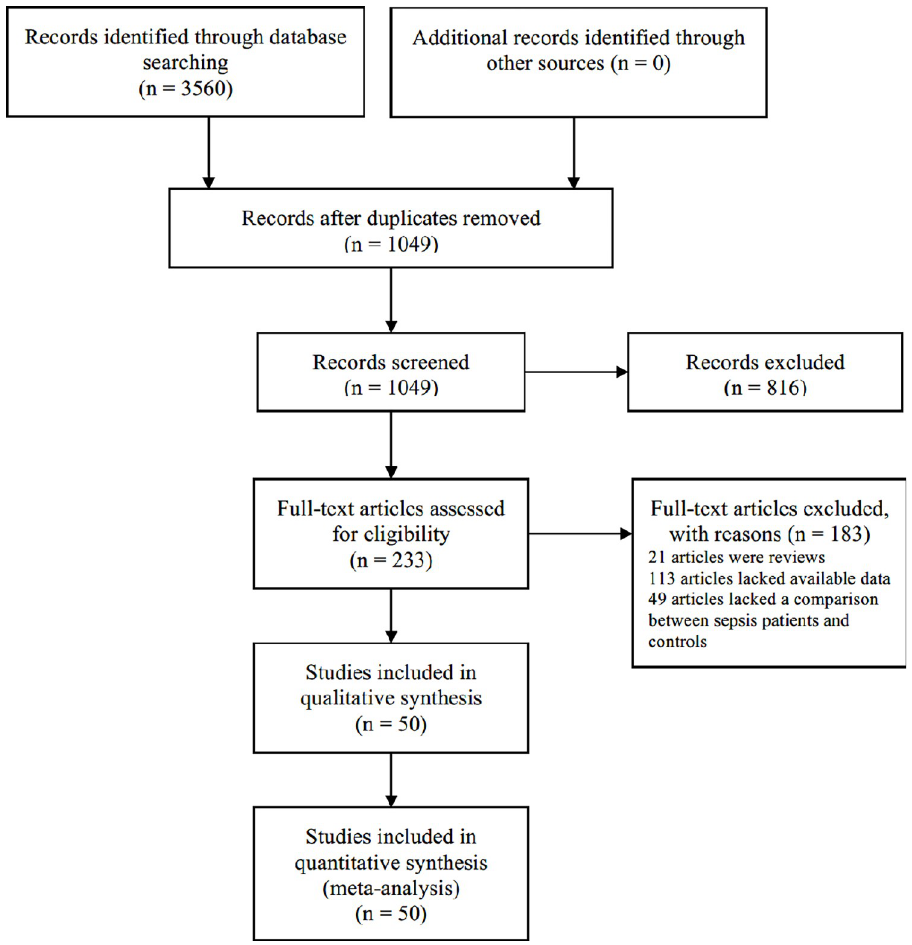
Fig 1. Flow diagram of the study selection